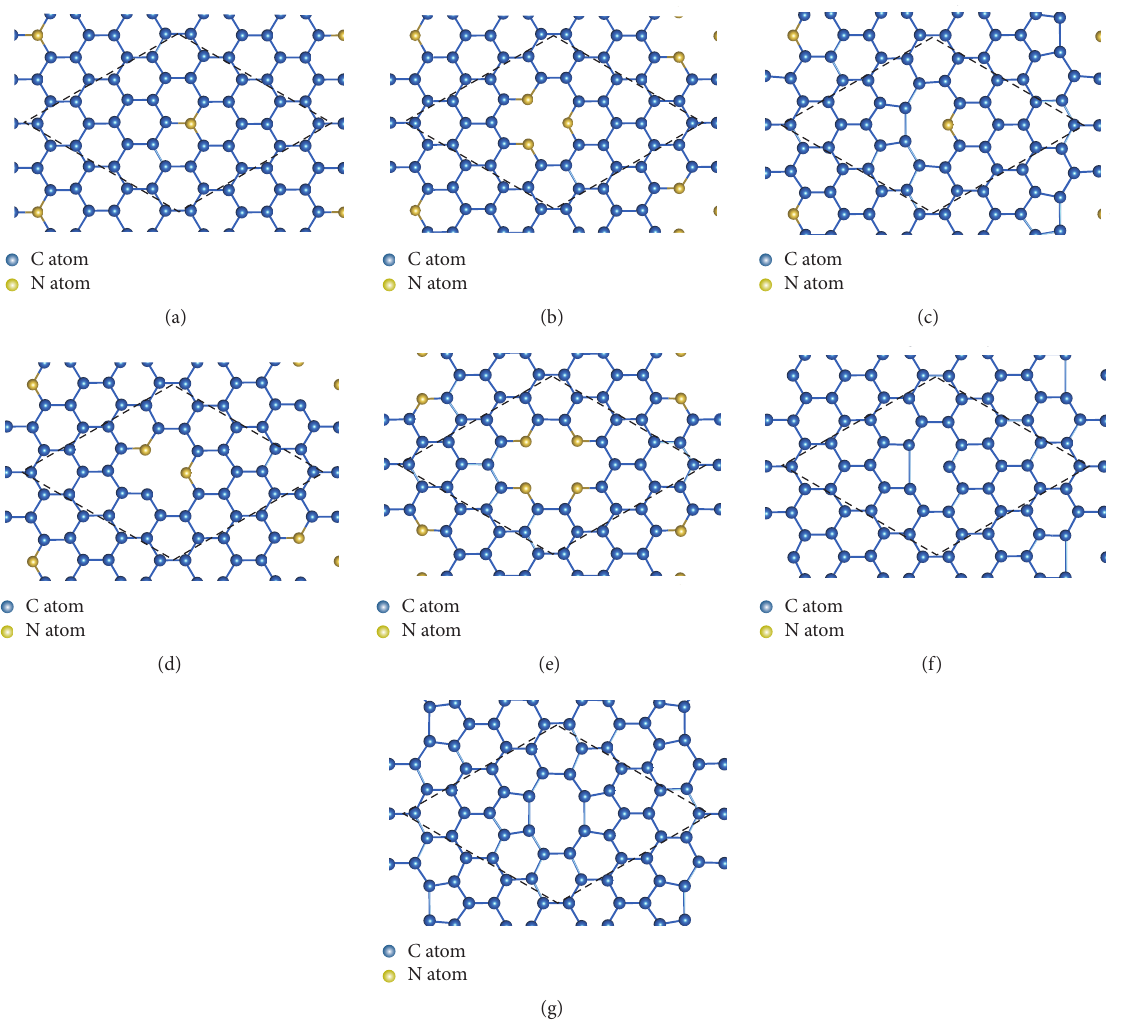
Figure 3: Atomic configurations of various N defects and undoped defective graphene. The dotted line denotes the unit cell. Atomic configurations of N-doped graphene and undoped defective graphene: (a) substitutional nitrogen defect (C 31 N), (b) trimerized pyridine- type defect (C 28 N 3 ), (c) monomeric pyridine-type defect (C 30 N), (d) dimerized pyridine-type defect (C 29 N 2 ), (e) tetramerized pyridine-type defect (C 26 N 4 ), (f) a monovacancy (C 31 ), and (g) a divacancy (C 30 ). In each case, the geometry is fully optimized in the framework of the density-functional theory. The dashed lines show the supercell. Reproduced with permission from [47], copyright 2011, the American Physical